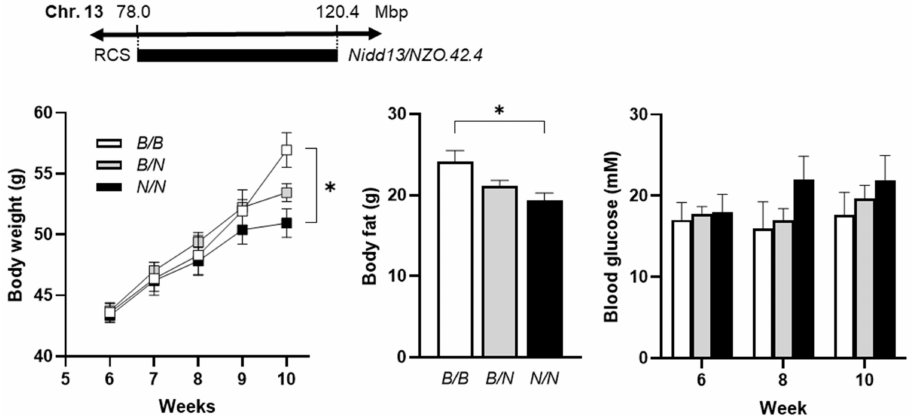
Figure 2. Phenotypic traits of congenic Nidd13/NZO mice. Male mice carrying 42.4 Mbp of chro- mosome 13 from NZO or B6 ( N/N , N/B , B/B ) on the NZO background were characterized for the development of body weight, body fat, and blood glucose on high-fat diet until 10 weeks of age. Data are presented as means ± SEM. * p < 0.05; B/B , n = 8–11; N/B , n = 31–33; N/N , n =